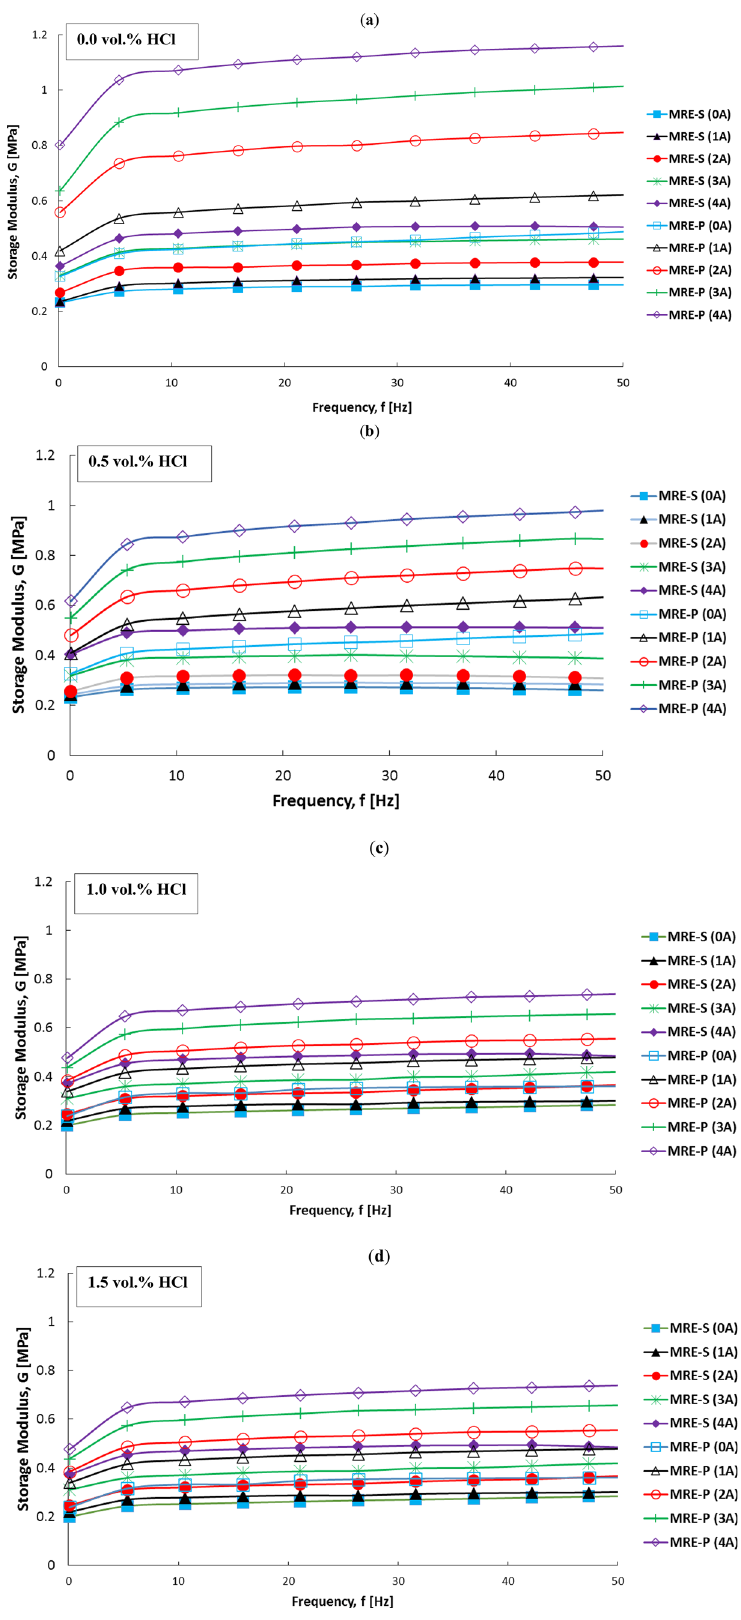
Figure 9. Variation of storage modulus of MRE samples towards frequency sweeps, containing spherical (filled symbol) and plate-like (unfilled symbol) CIPs, at different corrosion conditions of ( a ) 0, ( b ) 0.5, ( c ) 1.0 and ( d ) 1.5 vol.% HCl, under different applied magnetic